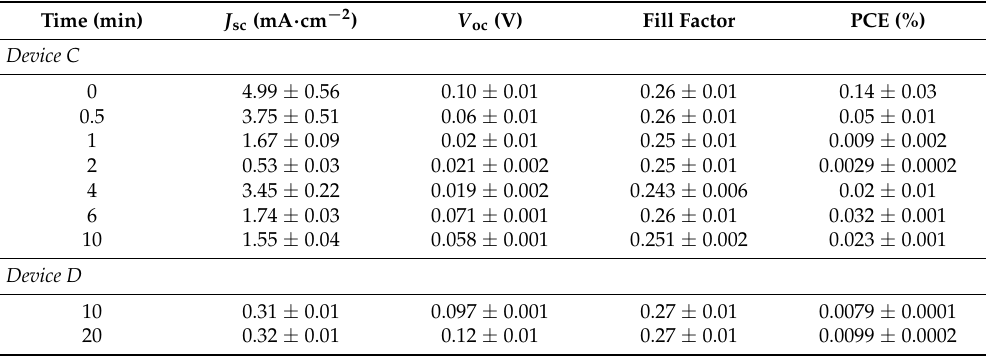
Table 2. Summary of the average solar cell parameters of devices C and D against the electrodeposition time of Mg(OH) 2 .